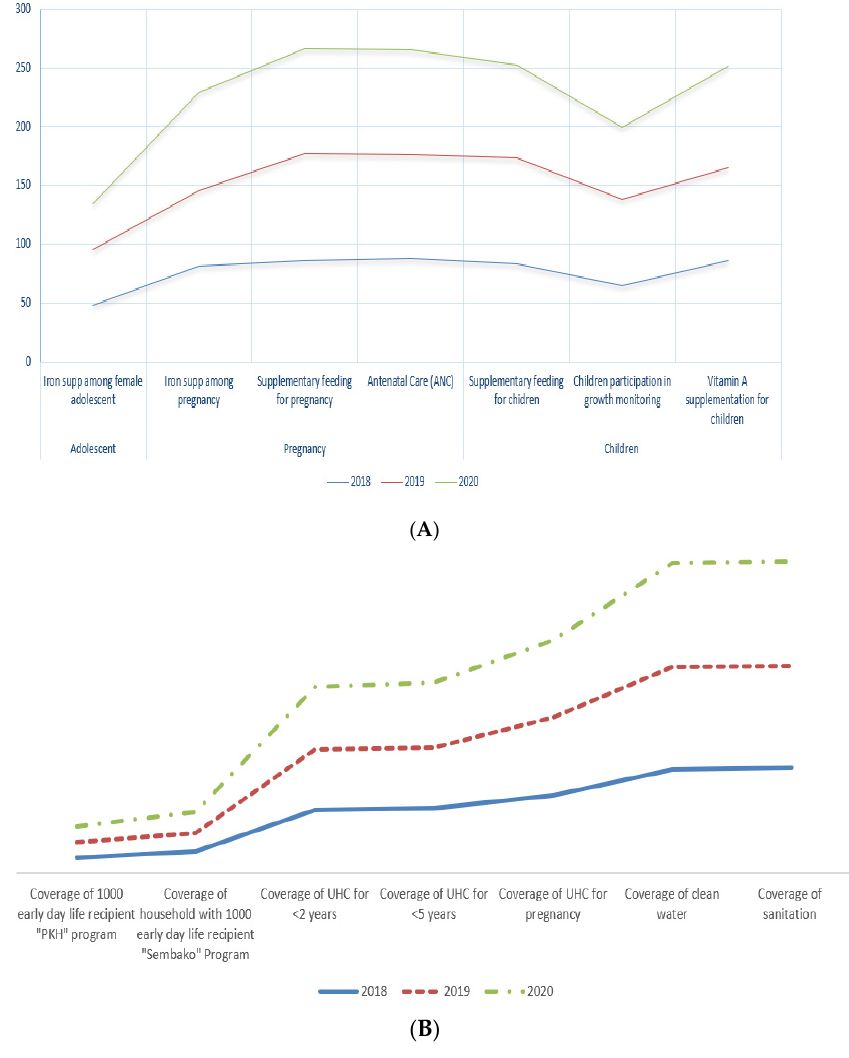
Figure 7. ( A ) Coverage of specific interventions for tackling stunting in children in Yogyakarta, 2018–2020; source: bangda.go.id. ( B ) Coverage of sensitive interventions for tackling stunting in children in Yogyakarta, 2018–2020; source: bangda.go.id.